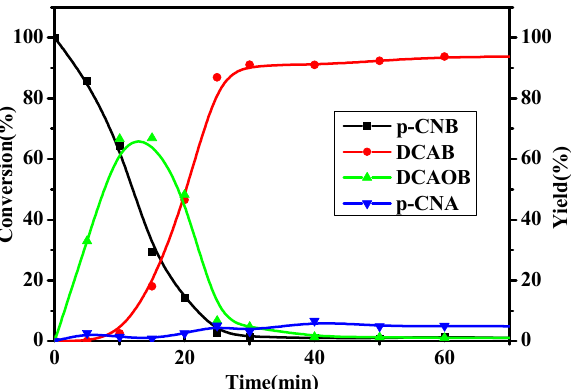
Figure 5. Substrate and product concentration profiles as a function of the reaction time.